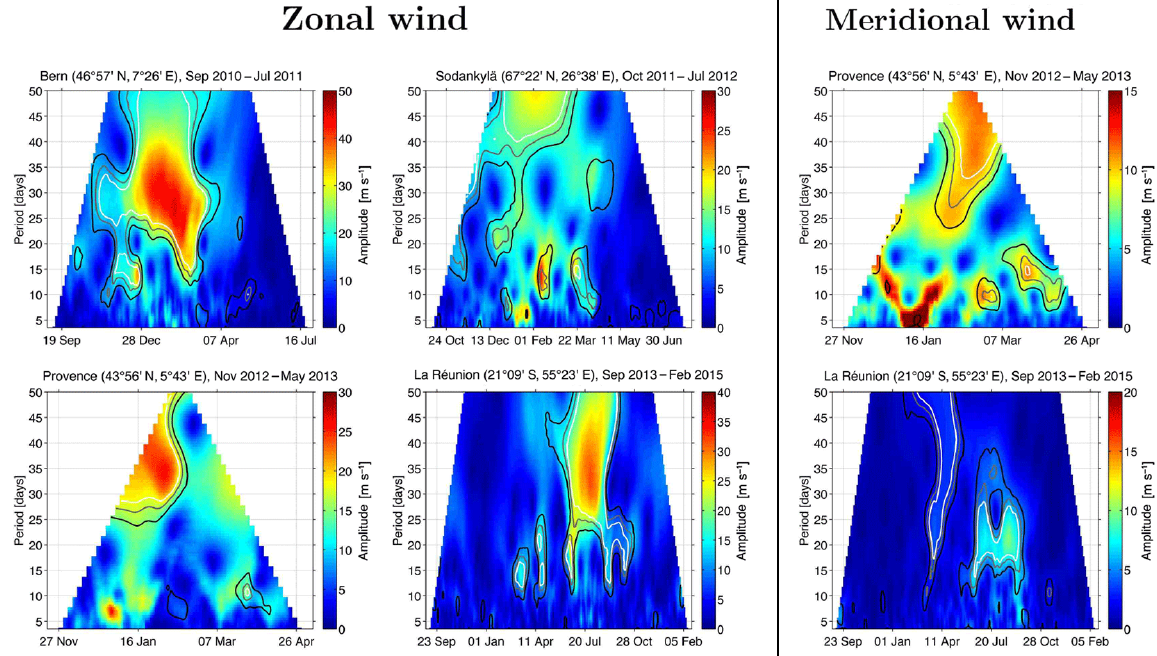
Figure 7. As Fig. 6 but for the unaltered daily average wind data from the ECMWF operational analysis.